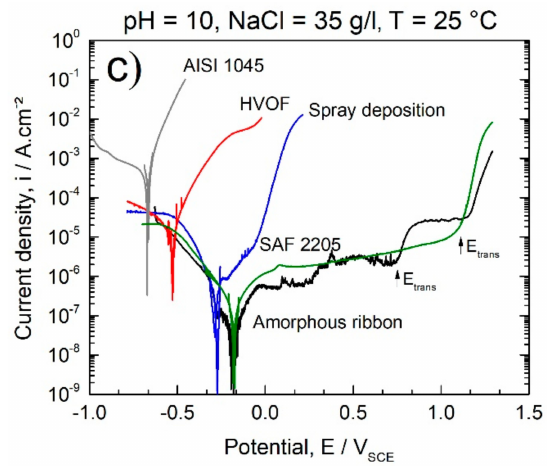
Figure 9. Polarization curves of 63.5Fe25Cr7Ni4.5B samples from melt-spinning, spray deposition, and the HVOF process analyzed in chloride-rich electrolyte, 35 g/L, at different pH: ( a ) pH = 3.0, ( b ) pH = 5.5, and ( c ) pH = 10.0. Results of AISI 1045 steel and of SAF 2205 stainless steel added for comparison purposes. E trans stands for transpassivation